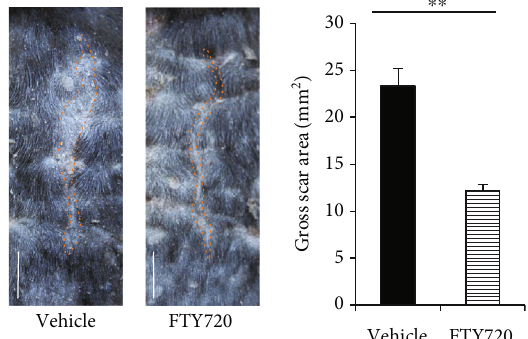
Figure 4: E ff ect of topical FTY720 injection on the gross scar area. Representative images of the gross scar area (dotted line) on Day 14 are shown. The gross scar areas on Day 14 were plotted ( n = 15 ). Five independent experiments were performed. Both showed similar results. The values shown represent means ± s : e : m : ∗∗ p < 0 : 01 , as determined by Wilcoxon signed-rank sum